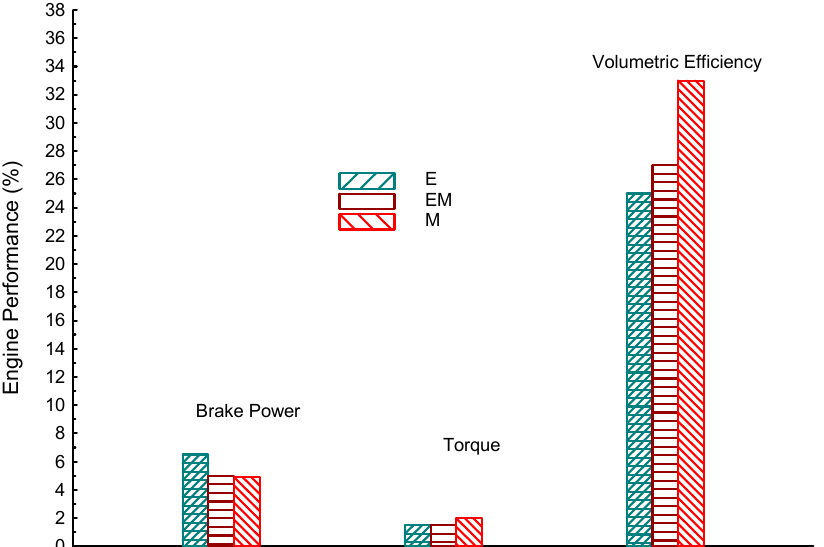
Figure 7. Comparisons of brake power, volumetric efficiency and torque for ethanol–methanol (EM), ethanol (E) and methanol (M) blended with gasoline and neat gasoline (baseline) in %.